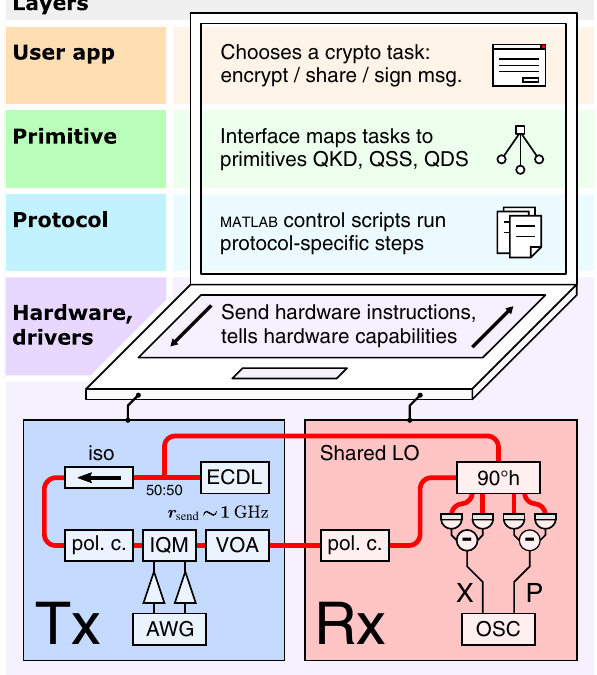
FIG. 4. Top: schematic drawing indicating how the different abstraction layers of quantum cryptoagility and versatility (see Fig. 2) are realized in our demo system as different pieces of software running on a laptop connected to our sender (Tx) and receiver (Rx) hardware. Bottom: the Tx and Rx modules used to perform four distinct quantum protocols, assuming different communication roles A , B , or C as shown in Fig. 3. ECDL, external-cavity diode laser; iso, isolator; VOA, variable optical attenuator; IQM, I/Q modulator; pol.c., polarization controller; AWG, arbitrary waveform generator; LO, local oscillator;